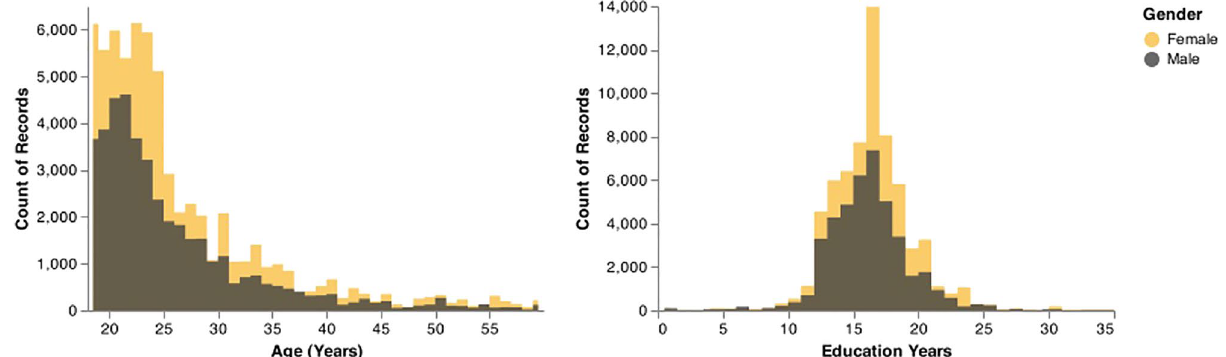
Figure 1. Distribution of age and education years by gender. Similar distribution of age and education years between males and